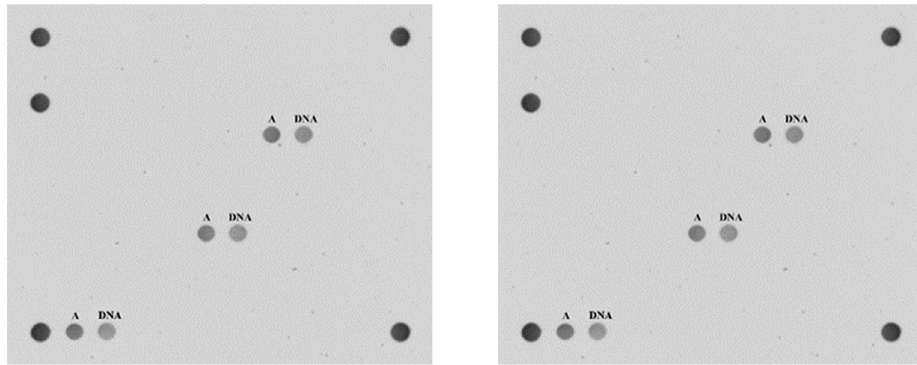
Figure 1. Both the amplification control (A) and genomic DNA control (DNA) are present in the sample of HPV-negative oropharyngeal squamous papilloma ( left ). In the sample of HPV-positive oropharyngeal squamous papilloma, type-specific amplification, HPV16 in this case, is detected via hybridization as well as the two internal controls ( right ).